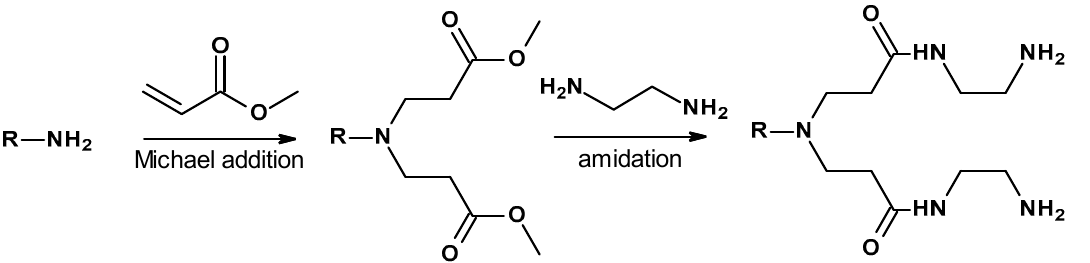
Figure 1. General scheme of PAMAM dendrimers preparation. The NH 2 -terminated structure represents full generations and the ester-terminated structure represents half-generations of PAMAM dendrimers.